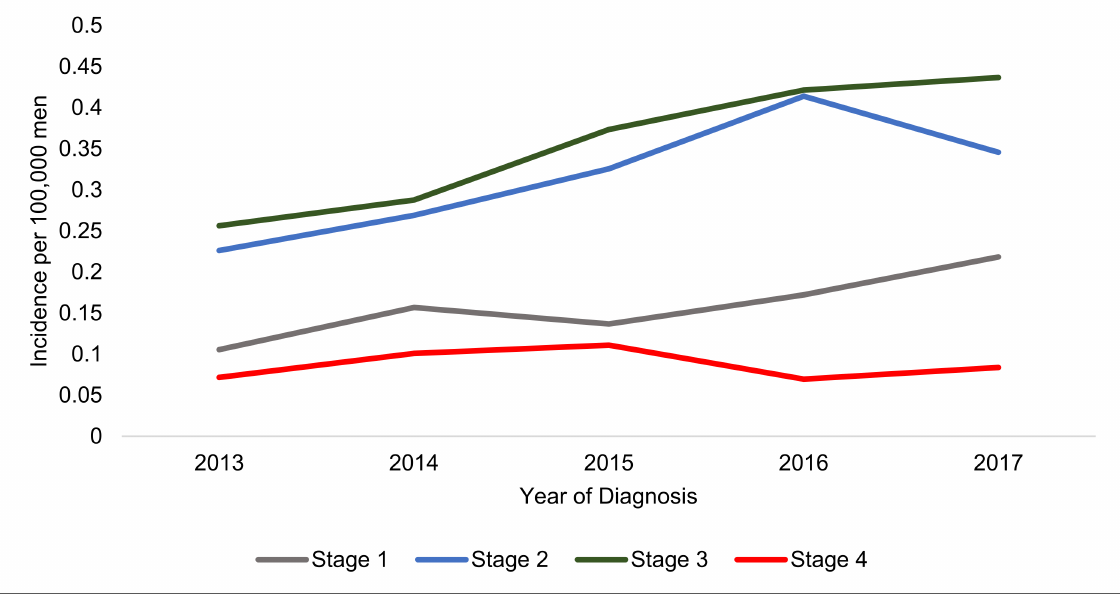
Figure 4. Incidence per 100,000 men in England from 2013–2017 stratified by stage. There appears to be two different patterns in incidence increase, male patients have a rapidly increasing incidence of Stage 1 cancers (Table 3), whereas female patients have a similar rapid increase in Stage 4 tumours over the five